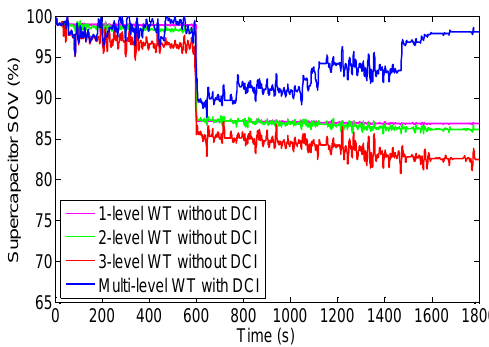
Figure 29. The state of voltage (SoV) comparison by adjusting combination of wavelet transform (WT) decomposition level. DCI, driving cycle identification.